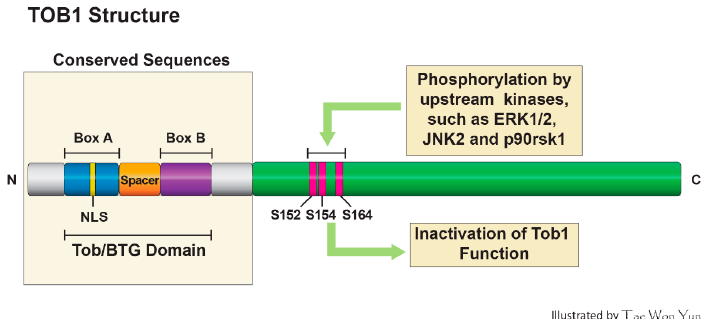
Figure 1. Structural features of TOB1 protein and its phosphorylation sites.